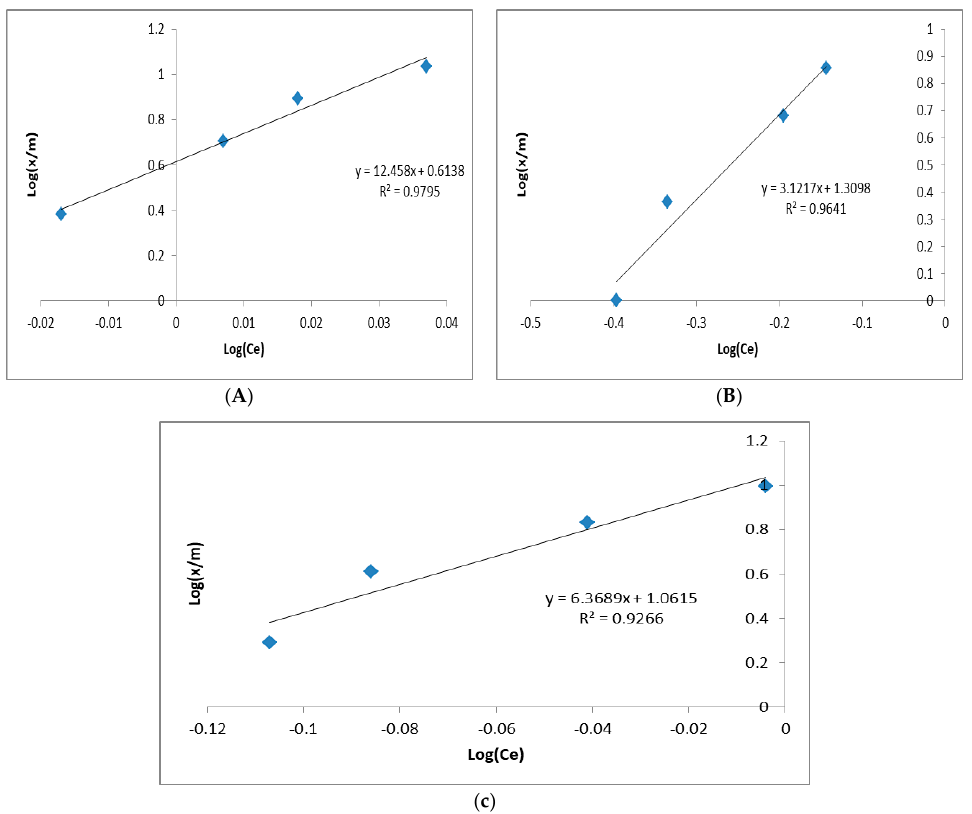
Figure 5. Freundlich isotherm regressions for ( A ) ammonia, ( B ) phenols, and ( C ) Mo.